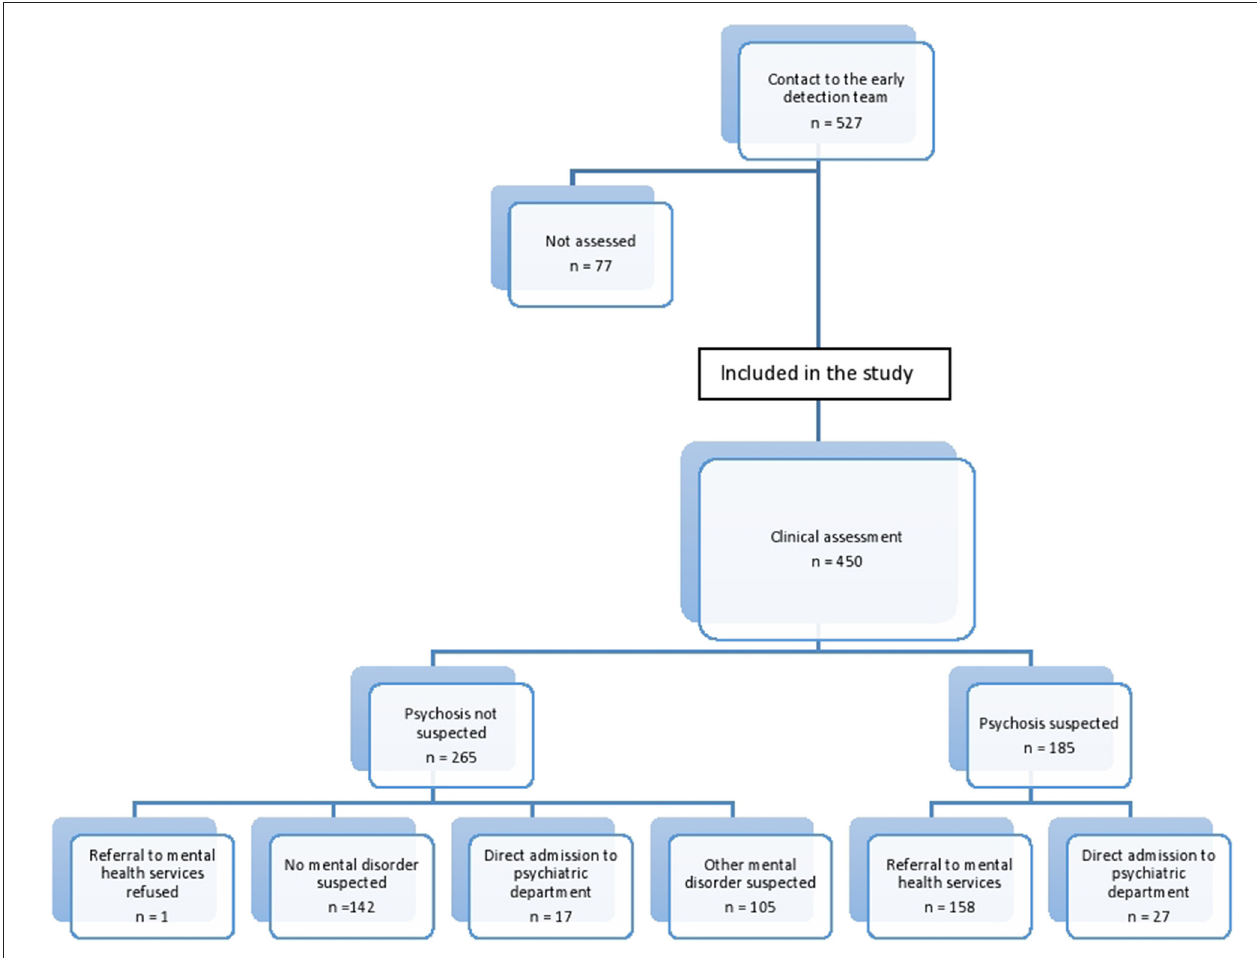
FIGURE 1 | Flow-chart of the study population, assessment by the early detection team and